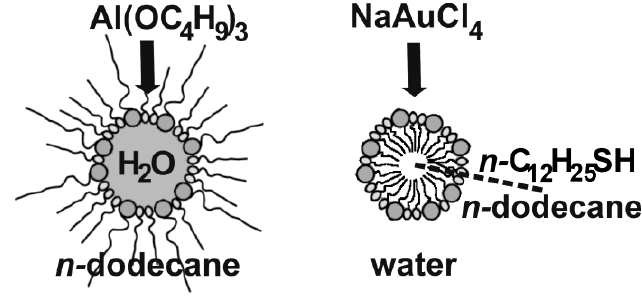
Figure 5. Scheme of hollow sphere formation applying w/o - and o/w -microemulsions with AlO(OH) and Au as concrete